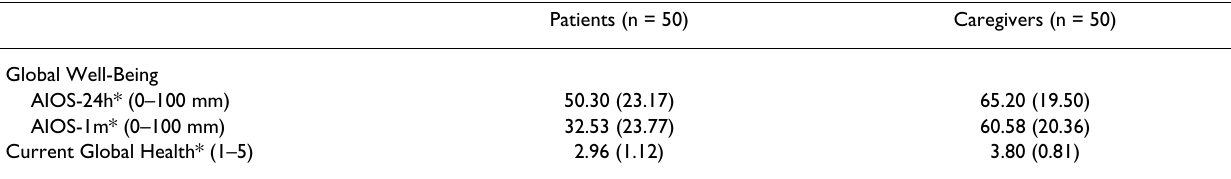
Table 1: Mean Scores for AIOS and Global Health Scale.